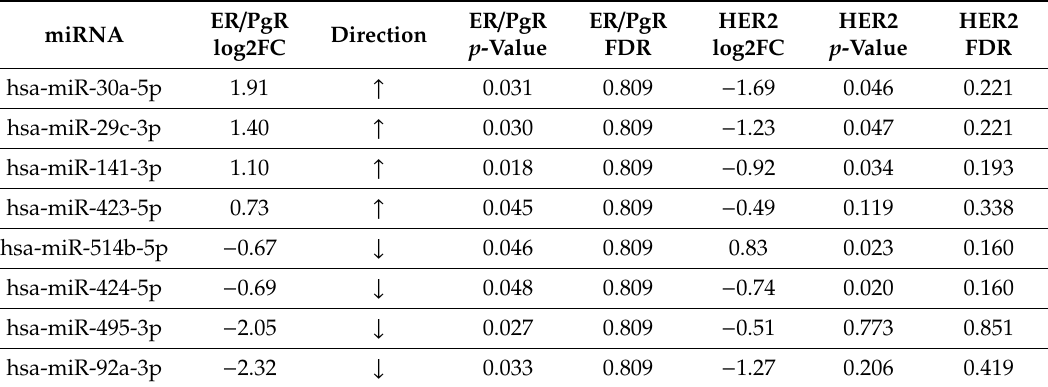
Table 4. ER / PgR-associated miRNAs in single hormone receptor-positive breast cancers; log2fold change (log2FC) calculated for the mean normalized counts of each probe in compared groups—ER( + ) / PgR( − ) vs. ER( − ) / PgR( + ); miRNAs upregulated in ER( + ) / PgR( − ) tumors are marked with ↑ , miRNAs downregulated in ER( + ) / PgR( − ) tumors are marked with ↓ ; di ff erences estimated with Two-Way ANOVA ( p -value) with Benjamini–Hochberg correction (FDR), only statistically significant results ( p -value ≤ 0.05) are presented; miRNA names according to the miRBase database (v21).